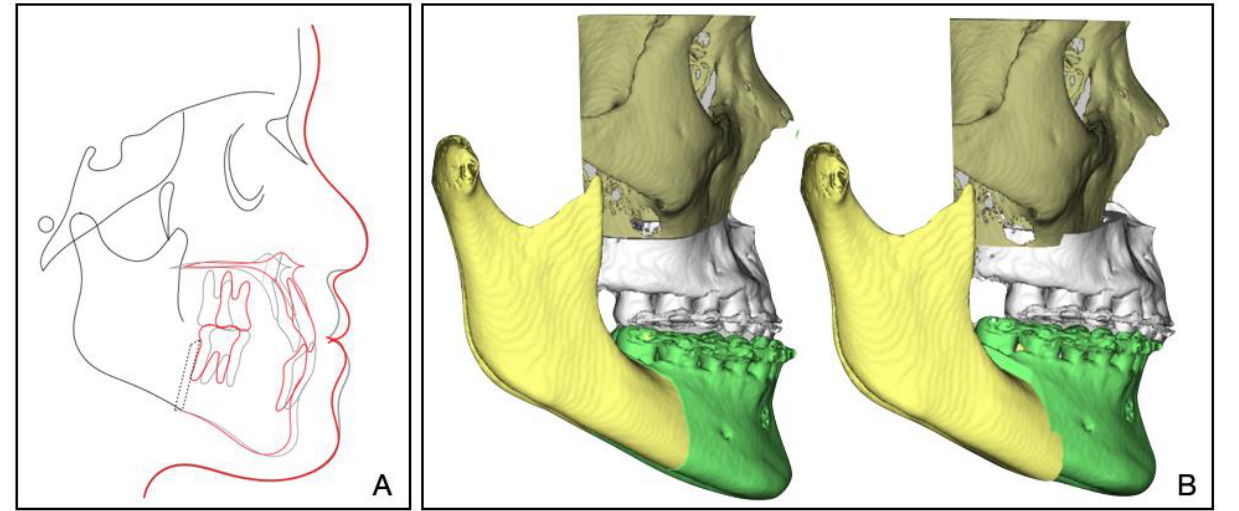
Figure 13. ( A ) VTO (Visual Treatment Objective): The postoperative effects were simulated by lateral radiographs. Pretreatment (black) and post-treatment (red). ( B ) Digital orthognathic surgery design through Dolphin software.